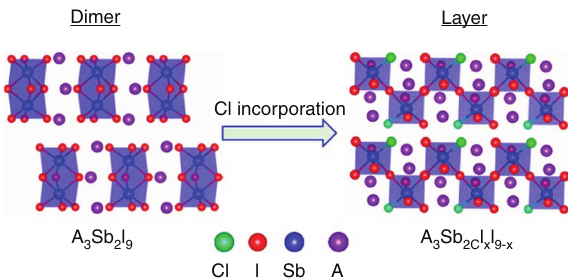
Figure 9: Schematic plot of the Cl-addition-induced transformation from the 0D dimer phase of A A Sb Cl I . 3 2 x 9− x Reprinted from Ref. [110] with permission from the American Chemical